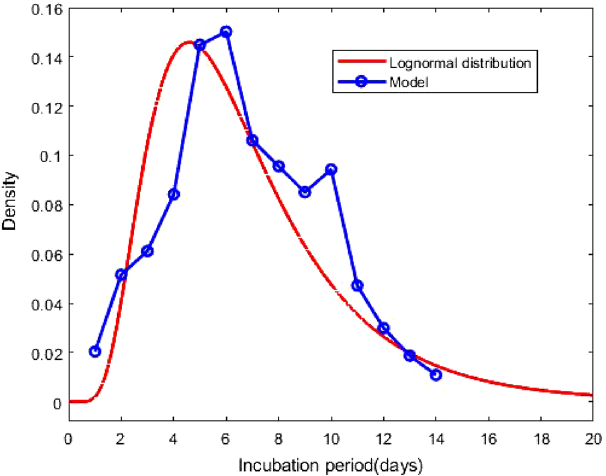
Figure 4. Probability density function of the lognormal distribution of the incubation period with µ = 1.79 and σ = 0.52 . The result based on the total confirmed corona cases of 276 days. The blue circles indicate the densities obtained from the model